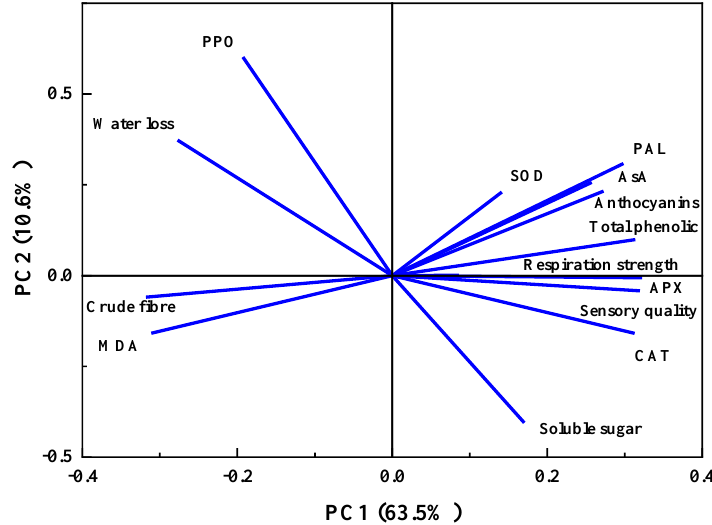
Figure 10. The map of two-dimensional principal component of 14 physiological parameters of ‘Dianhong’ rose petals.